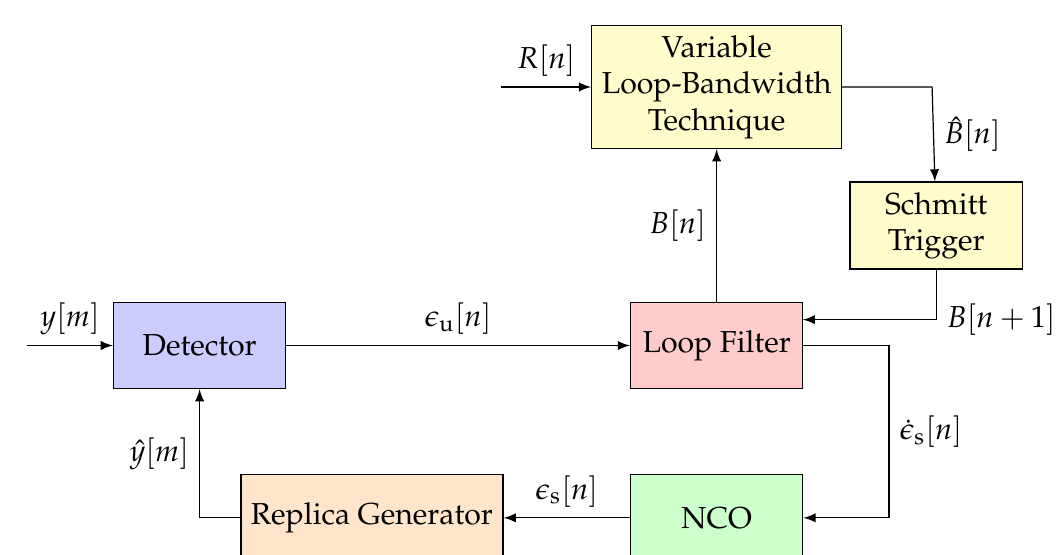
Figure 5. General architecture of the implemented variable loop-bandwidth tracking